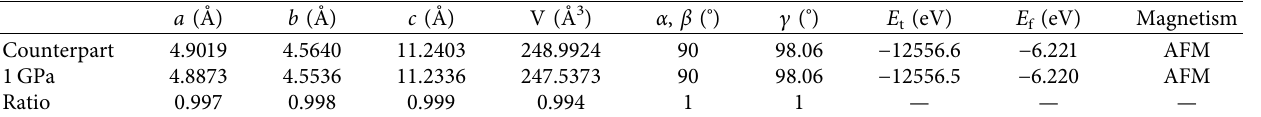
Table 1: Lattice parameters, total energy, formation enthalpy, and magnetism of sandwiched Ca